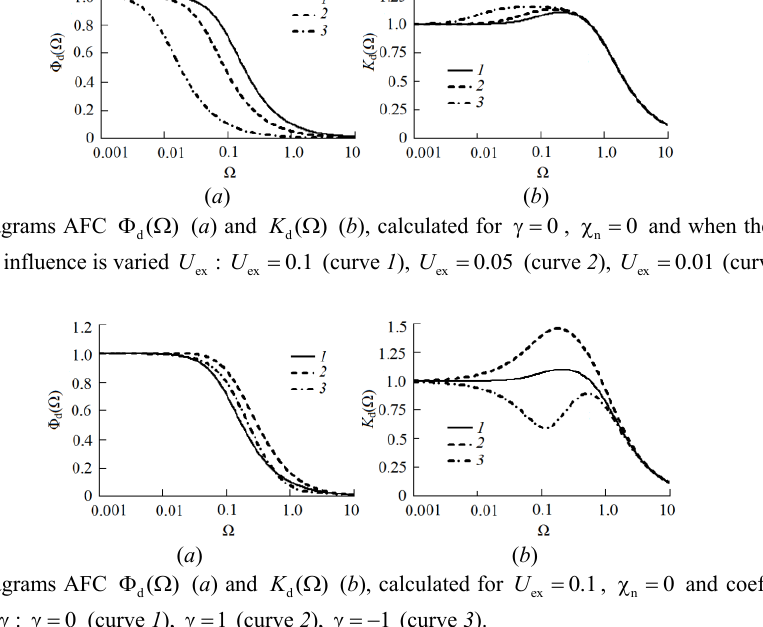
( )   ( a ) and ( ) K  ( b ), calculated for d d 1   (curve 2 ), 1    (curve 3